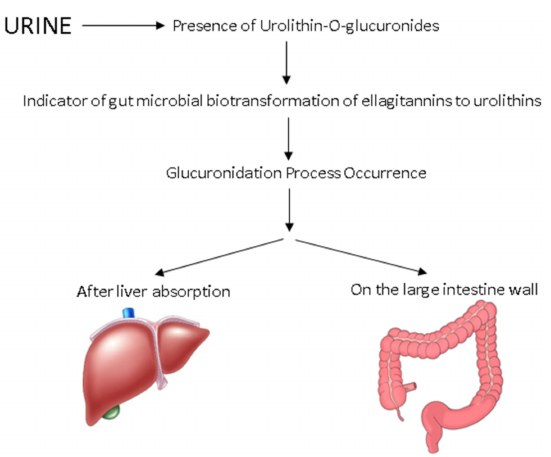
Figure 7. Hypothesis of in vivo gut microbial biotransformation of ellagitannins to urolithins pro- posed by Gonz á lez-Barrio et al.